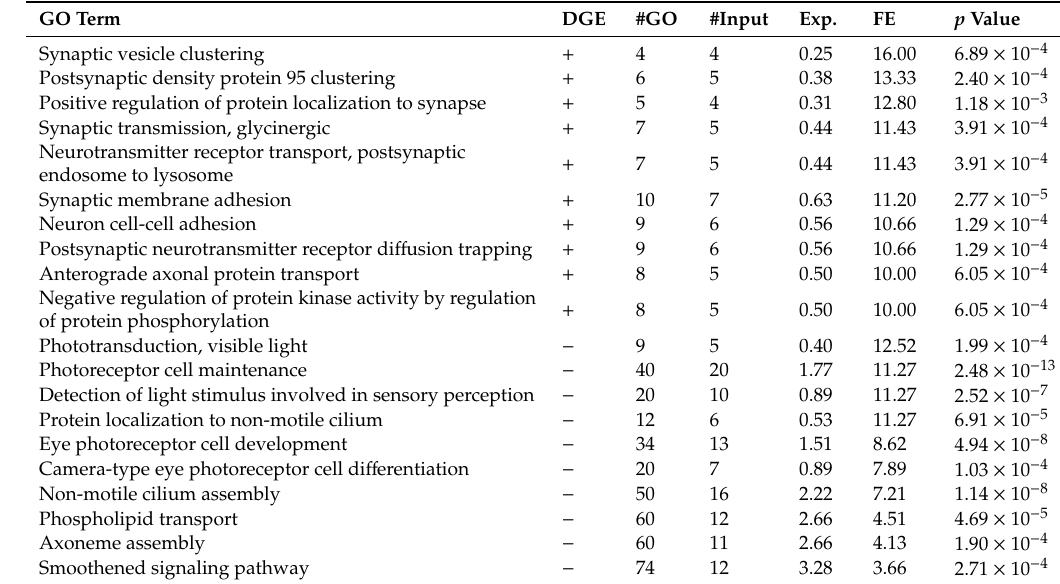
Table 1. Top 10 enriched GO terms of up- and downregulated genes in adult Lgr5 + compared to Lgr5 − . DGE: Input from up ( + ) or downregulated ( − ) genes from di ff erential gene expression; #GO: number of genes in the GO term; #Input: number of genes in the input list; Exp.: expected number of genes in the input list; FE: fold enrichment.